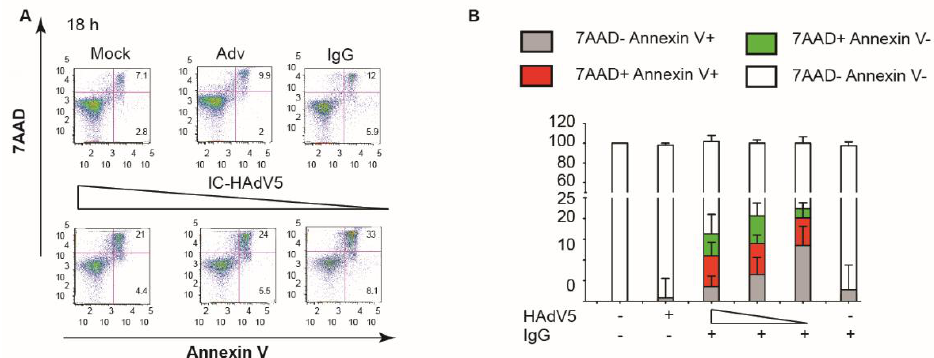
Figure 5. IC-HAdV5 caused autophagy and apoptosis in pDCs. ( A ) Representative flow cytometry profile of pDCs challenged with IgG, HAdV5, and IC-HAdV5 (40,000 to 10,000 pp/cell), then incubated with anti-Annexin V antibodies and assayed by flow cytometry at 18 h. ( B ) pDCs were challenged with IgG, HAdV5, and IC-HAdV5 (40,000 or 20,000 pp/cell), then incubated with Annexin V and assayed by flow cytometry at 18 h. The quadrants were set for 7AAD-/Annexin V- (white), 7AAD-/Annexin V+ (grey), 7AAD+/Annexin V+ (red), and 7AAD+/Annexin V- (green). The percentage of each subpopulation at each condition is depicted in the histogram. These assays were performed in three donors, with similar results.